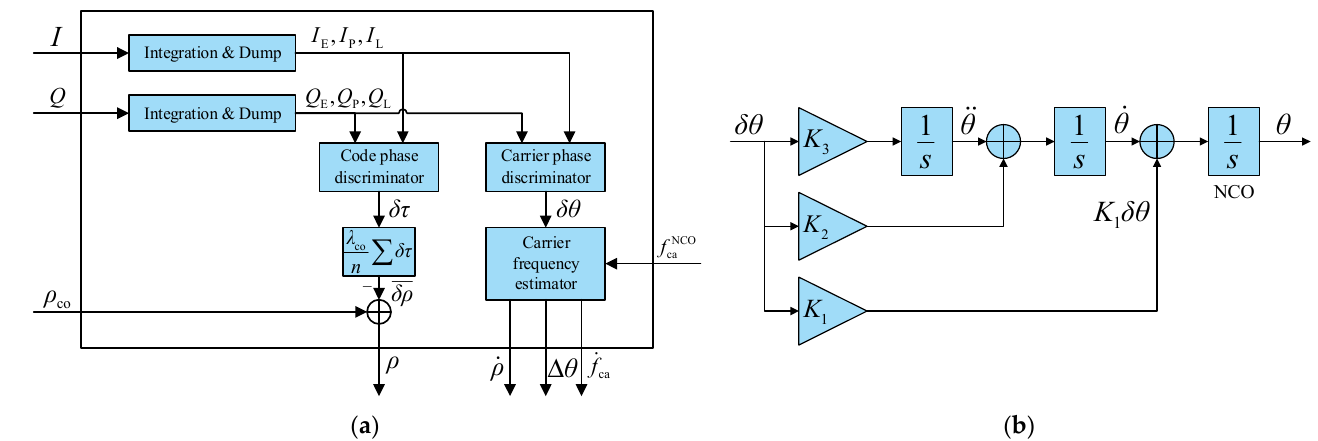
Figure 3. ( a ) Diagram of pseudorange and pseudorange rate measurement; ( b ) structure of the third-order loop filter.